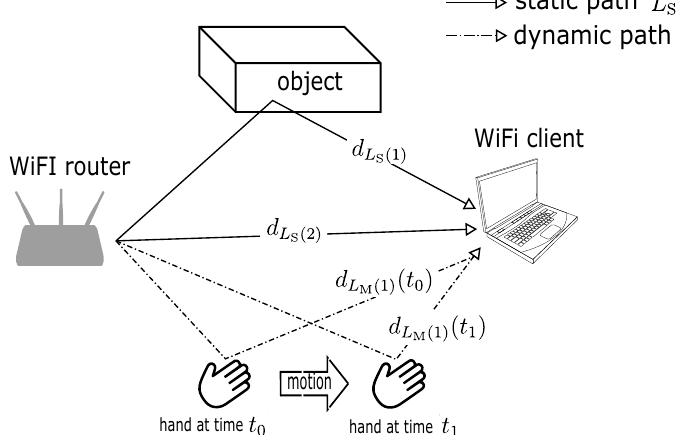
Figure 1. Propagation of Wi-Fi signal in multipath channel interacting with static object and hand in